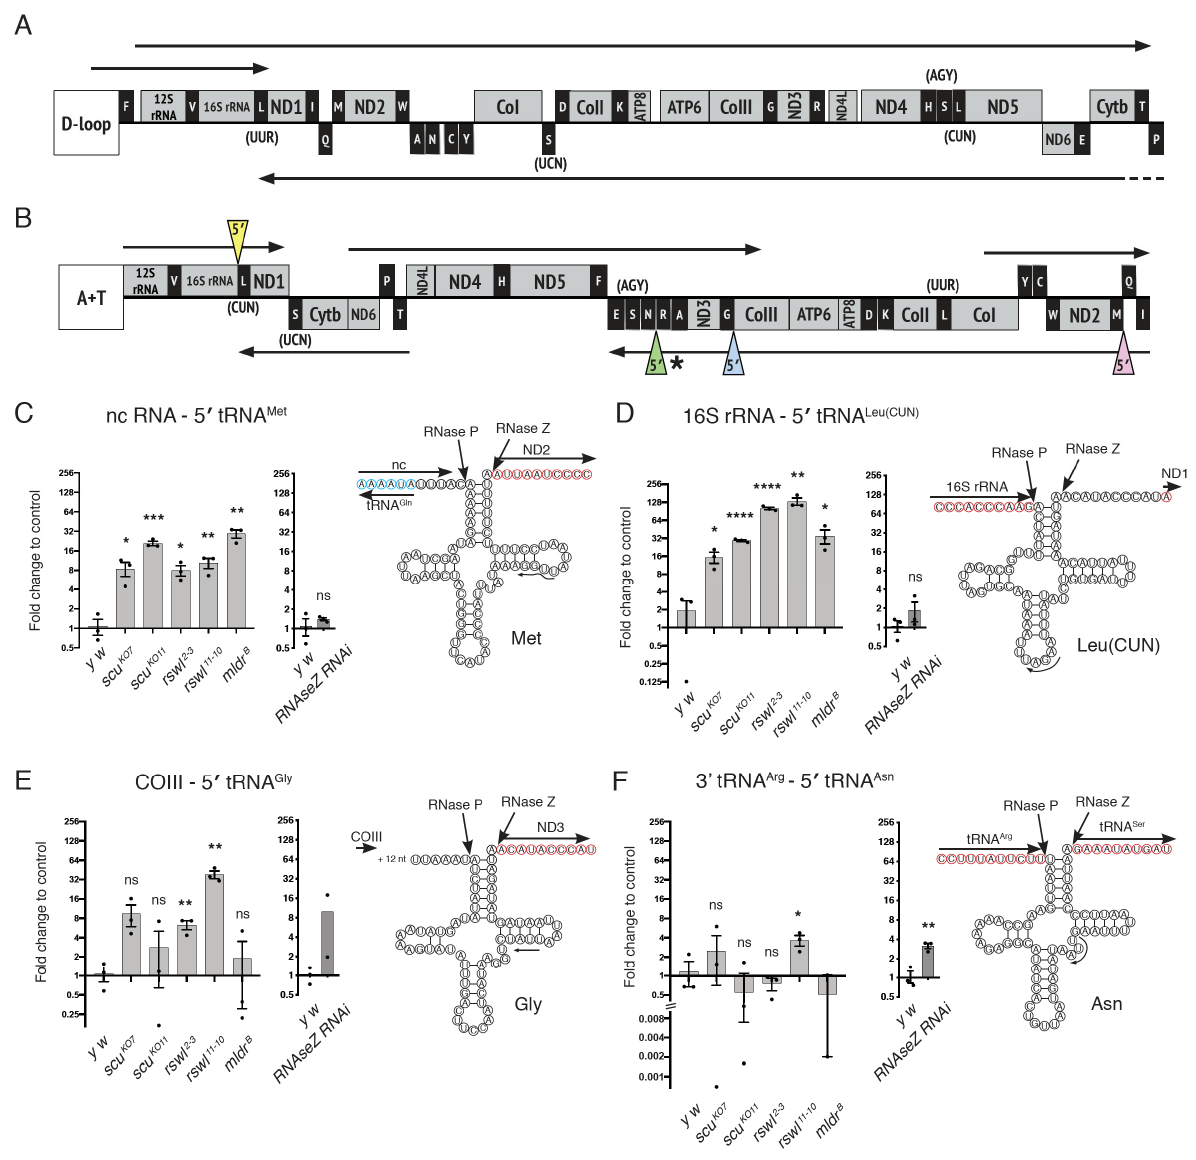
Figure 3. Mutations in mtRNase P complex proteins differentially affect mt:tRNA 5 ′ -end processing. ( A , B ) Linear schematic of human ( A ) and Drosophila ( B ) circular mtDNA. Protein coding regions (mRNA) and ribosomal RNA (rRNA) are depicted in grey, whereas mt:tRNAs are in black. Both mtDNAs encode the same products in a slightly different order. Arrows indicate polycistronic transcripts, with humans containing three and Drosophila , five. The non-coding regions that control replication (human and Drosophila ) and transcription (human) are the displacement ( D ) loop and the A+T region that is rich in adenine and thymine. The mt:tRNA 5 ′ -ends tested are indicated with colored triangles ( B ). The asterisk indicates a junction that could also be recognized and cleaved at the mt:tRNA 3 ′ -end. ( C – F ) Graphs representing the log 2 fold change in qPCR levels and the corresponding predicted mt:tRNA cloverleaf structure for mt:tRNA 5 ′ -end canonical junctions between ( C , pink triangle) non-coding (nc) RNA: 5 ′ tRNA Met ; ( D , yellow triangle) 16S rRNA: 5 ′ tRNA Leu(CUN) ; ( E , blue triangle) COIII: 5 ′ tRNA Gly ; ( F , green triangle) 3 ′ tRNA Arg : 5 ′ tRNA Asn for scu , rswl, mldr , and UAS - RNaseZ RNAi mutant larvae. The arrow within each tRNA diagram indicates the internal primer start site for qPCR analysis. The red circled nucleotides represent 5 ′ -> 3 ′ mtRNA, and the blue represents mt:tRNA encoded on the opposite strand. Bars on the graphs represent averaged 2^ddCt, and the y-axis is log 2 . Further explanation can be found in the materials and methods. The statistical significance was calculated relative to control ( y w ). Error bars: S.E.M. calculated using GraphPad PRISM using an unpaired t -test, one-tailed. * p < 0.05; ** p < 0.01; *** p < 0.001; **** p < 0.0001; ns: not